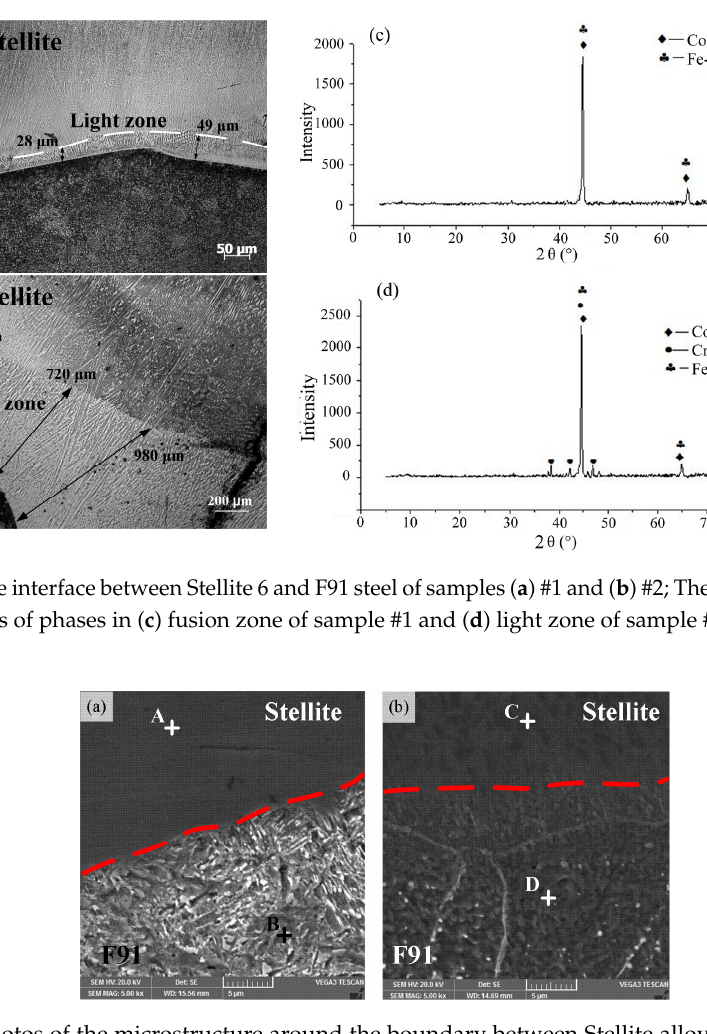
Figure 3. The interface between Stellite 6 and F91 steel of samples ( a ) #1 and ( b ) #2; The X-ray diffraction (XRD) results of phases in ( c ) fusion zone of sample #1 and ( d ) light zone of sample #2.